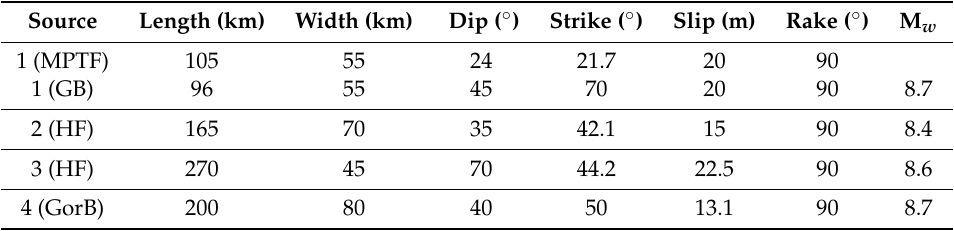
Table 1. Earthquake source parameters used in this study to model the Lisbon 1755 event.